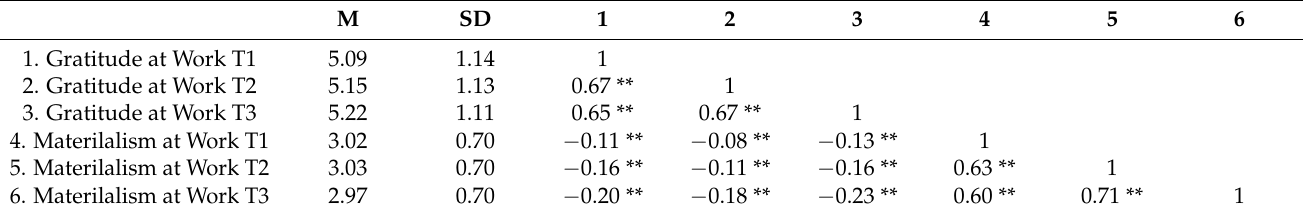
Table 1. Descriptives and Zero-order Correlations Between all Variables at T1, T2 and T3.